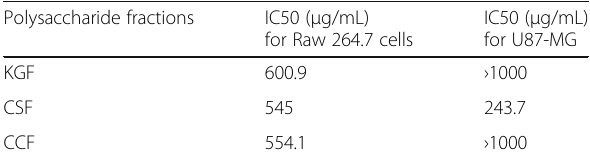
Table 3 Inhibitory concentration 50 for Raw 264.7 Macrophages and U87-MG Glioblastoma cells line with respect to polysacchar- ide fractions of K. grandifoliola stem bark , C. sanguinolenta and C. citratus leaves Polysaccharide fractions